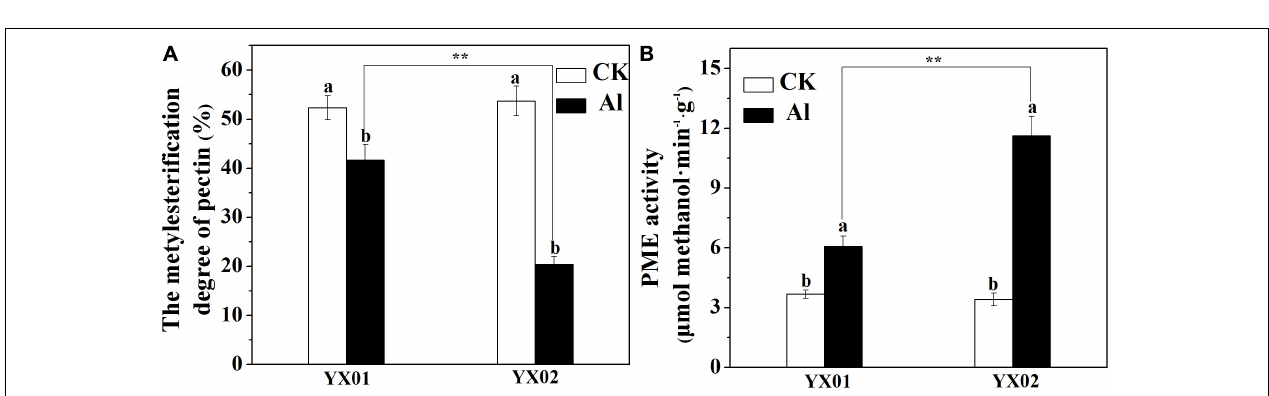
FIGURE 5 | Effects of Al treatment on uronic acid content in root tips of Chinese fir seedlings. Two-month-old Chinese fir seedlings were exposed to 1/2 strength complete nutrition solution without Al (CK), or with 1 mM AlCl 3 (Al) for 16 d. After treatment, cell wall was extracted from root tips of Chinese fir and fraction into pectin (A) , HC1 (B) , and HC2 (C) for uronic acid measurement. Bars are means of four replicates ± SD. Different letters above histogram represent significant differences at P < 0.05 . * or ** above lines represent significant differences between genotypes at P < 0.05 and P < 0.0 1, respectively.